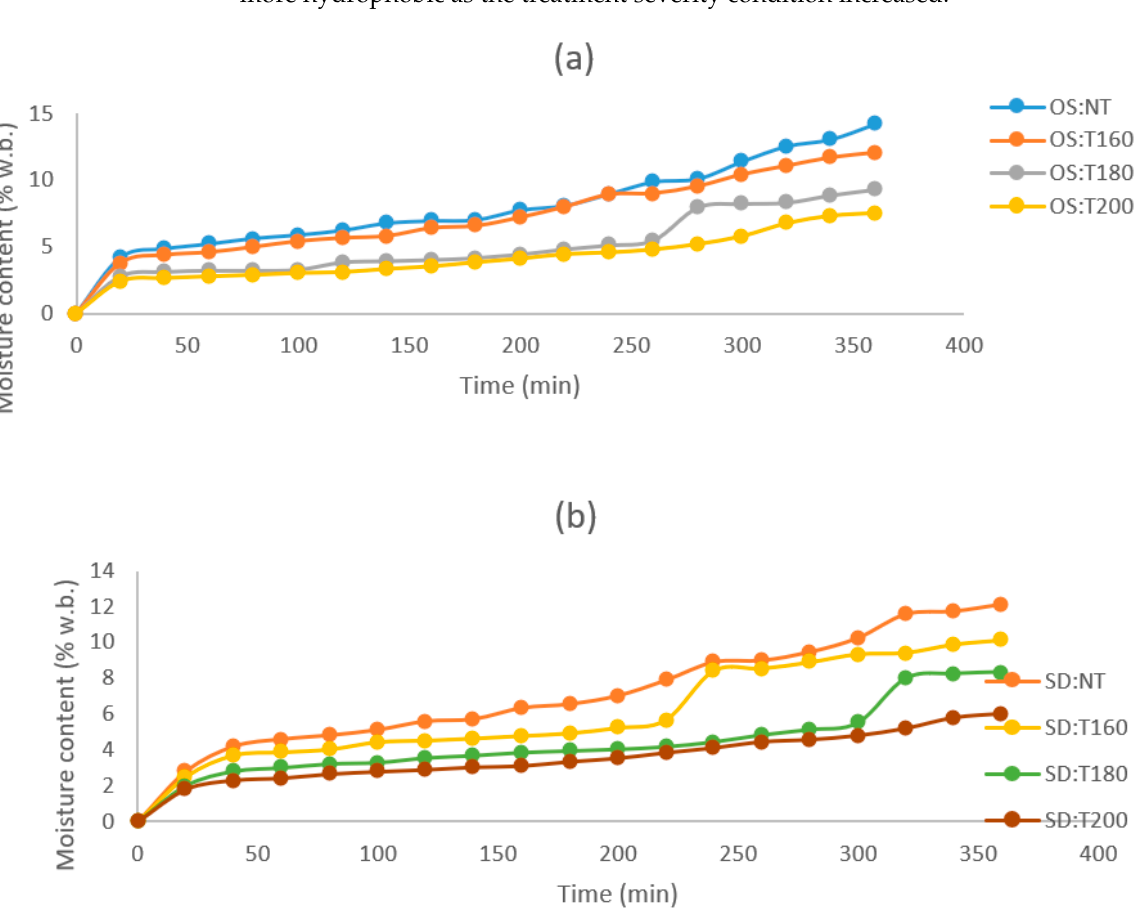
Figure 4. Moisture absorption of steam-treated and non-treated oat straw ( a ) and sawdust ( b ) pellets. OS: NT (oat straw: untreated); OS: T160 (oat straw: steam exploded at 160 ◦ C); OS: T180 (oat straw: steam exploded at 180 ◦ C); OS: T200 (oat straw: steam exploded at 200 ◦ C); SD: NT (sawdust: untreated); SD: T160 (sawdust: steam exploded at 160 ◦ C); SD: T180 (sawdust: steam exploded at 180 ◦ C); SD: T200 (sawdust: steam exploded at 200 ◦